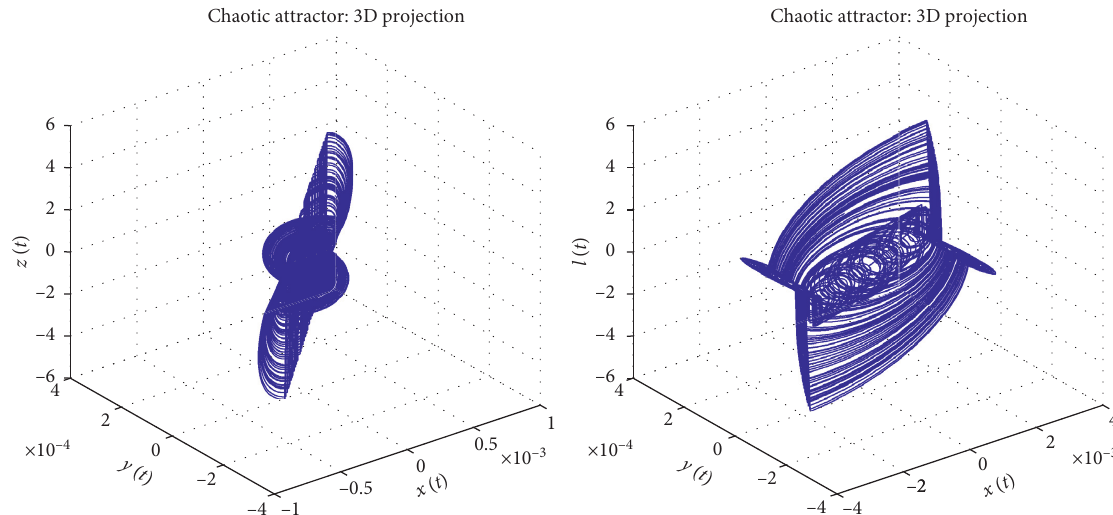
Figure 8: Chaotic attractor in the three-dimensional space based on the encryption method.